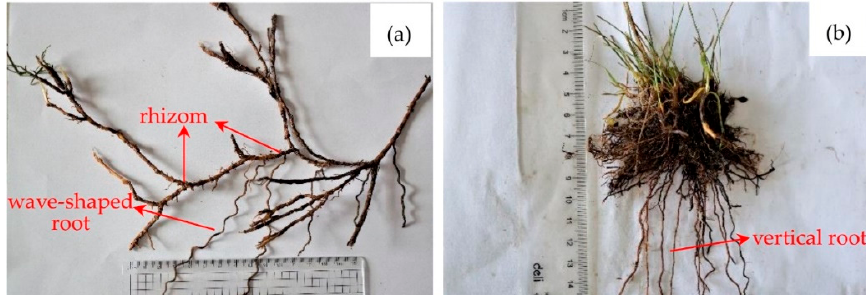
Figure 8. ( a ) The laterally distributed and wave-shaped root system of Blysmus sinocompressus in AS; ( b ) the distribution of straight roots in Kobresia pygmaea of AM. ( b ) the distribution of straight roots in Kobresia pygmaea of